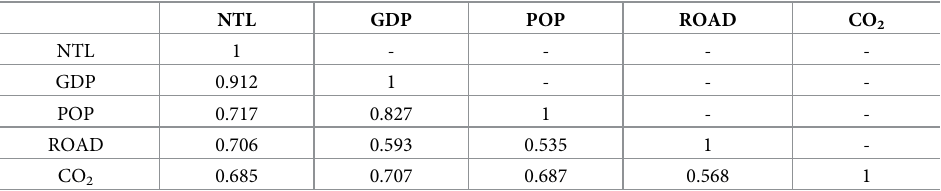
Table 3. Pearson’s correlation coefficient between the total NTL and each factor at provincial level in China.